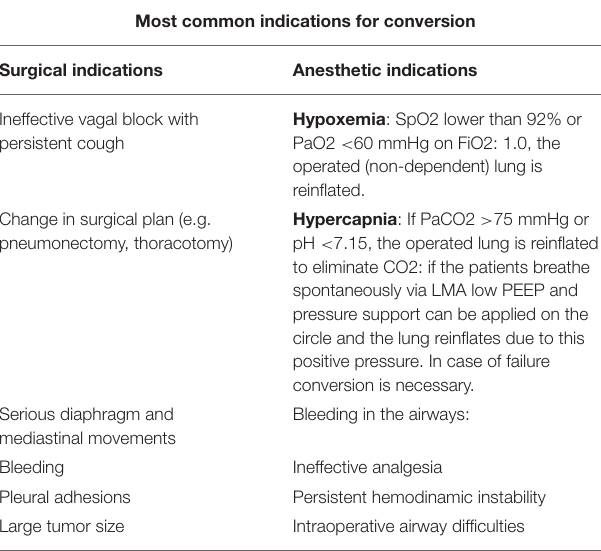
TABLE 3 | Most common indication for conversion. Most common indications for conversion Surgical indications Anesthetic indications Ineffective vagal block with persistent